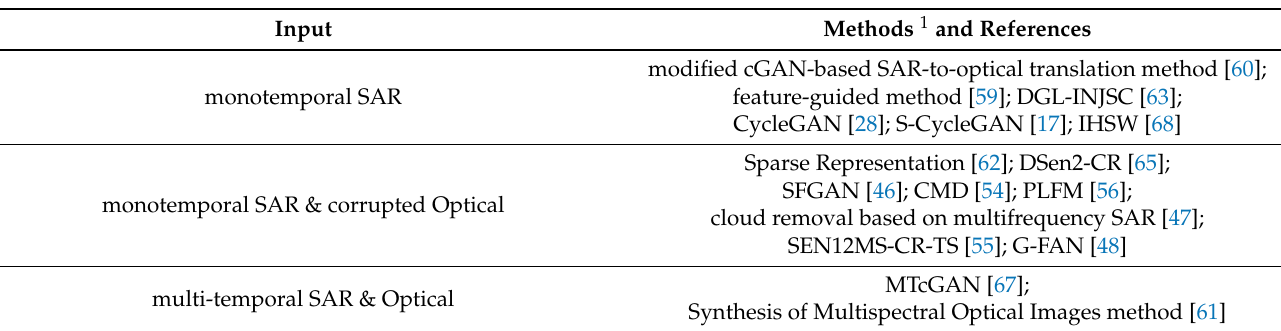
Table 3. Different inputs of the existing cloud removal methods of optical remote sensing imagery using SAR. ( 1 Names of these methods were extracted from the literature. If the methods were not named in the literature, the words describing the methods’ major characteristics were used to name them here. cGANs: conditional generative adversarial networks. CNNs: convolutional neural